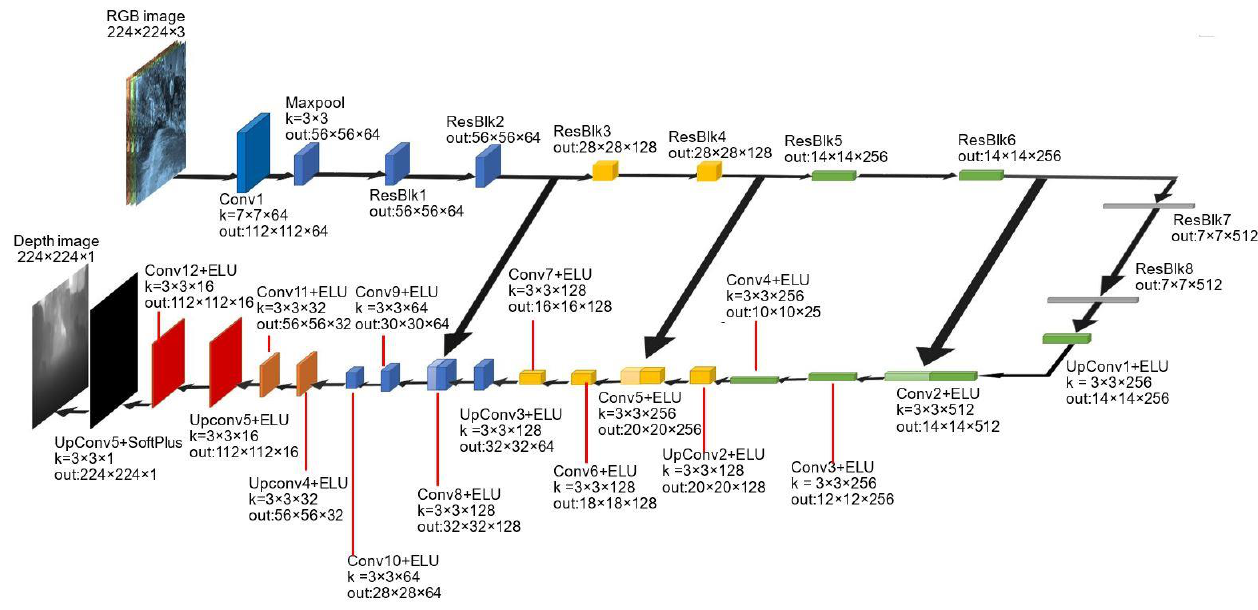
Figure 2. The depth estimation subnetwork.